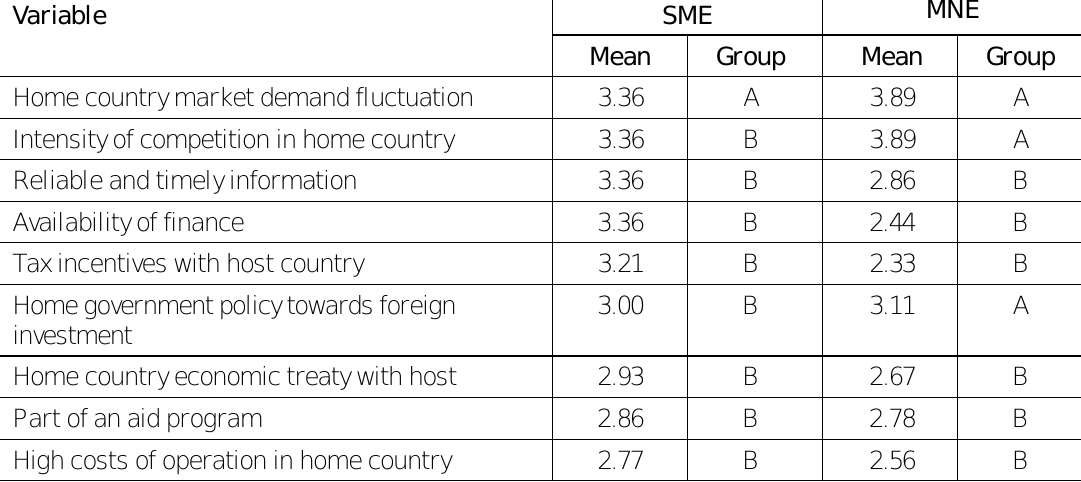
Table 3: SME home country factors descending means and equal mean sub-groups